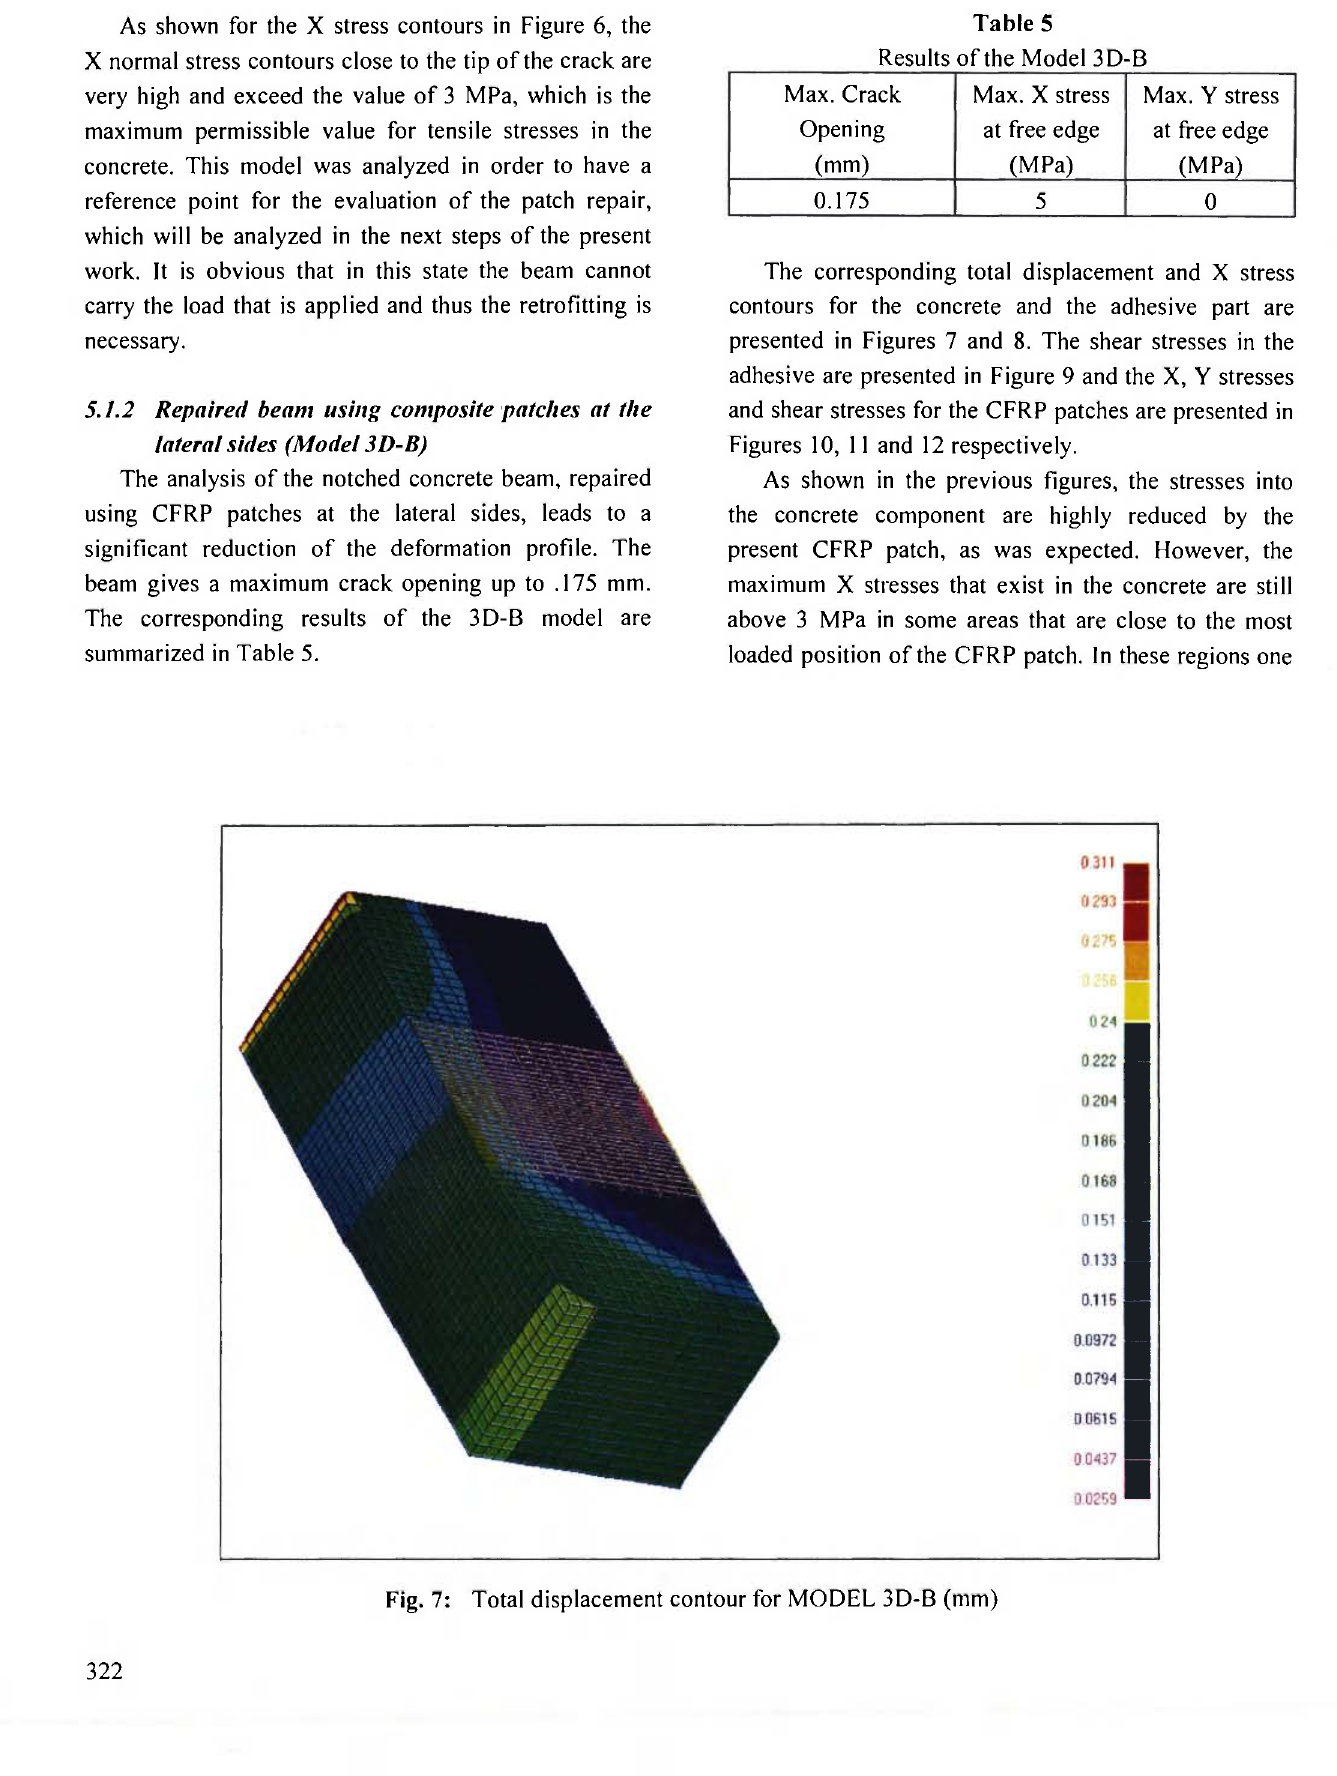
Fig. 7: Total displacement contour for MODEL 3D-B